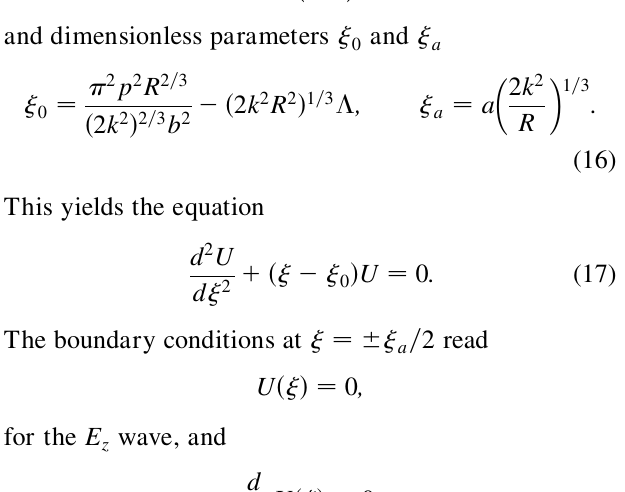
mode: r mode: blue (indicated z